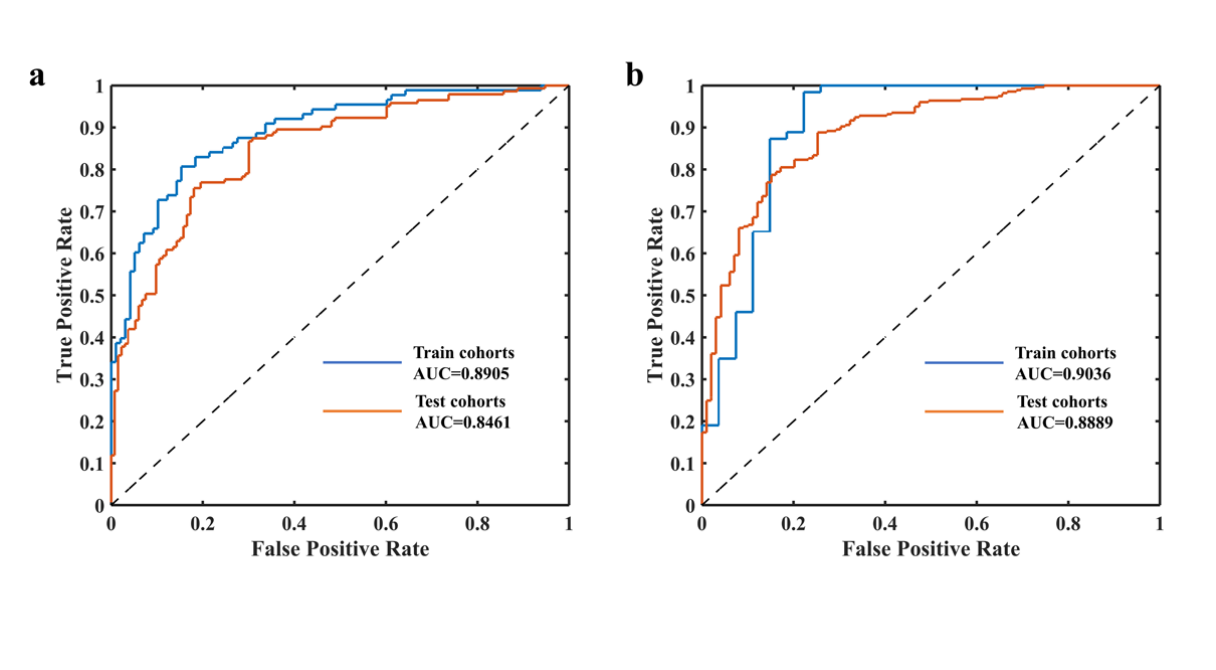
Figure 3. Receiver operating characteristic curves (ROC) of the performance evaluation for (a) differentiation degree prediction of extrahepatic cholangiocarcinoma in the training and testing cohorts and (b) lymphatic node metastasis of extrahepatic cholangiocarcinoma in the training and testing cohorts. AUC: area under the curve.